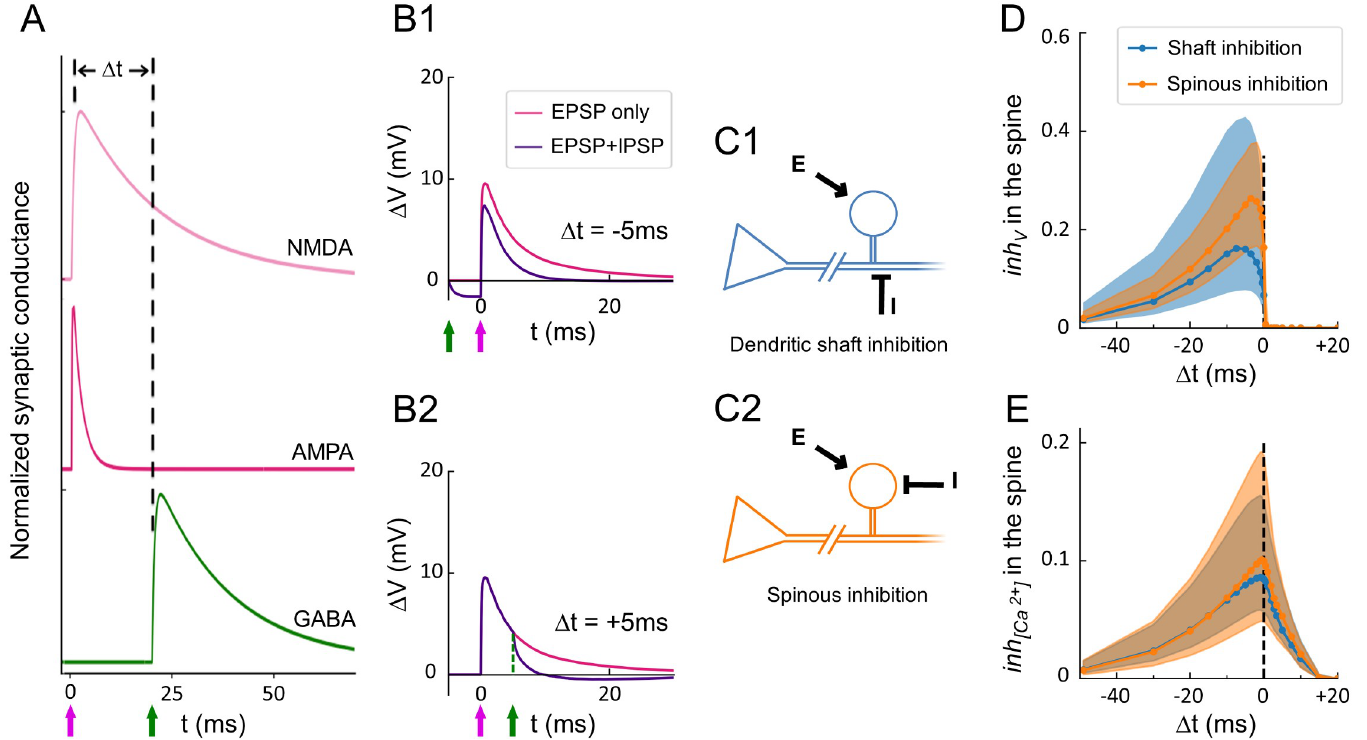
Fig 7. Input timing determines EPSP and IPSP integration and decoupling of voltage and calcium signals in DiSs. (A) Schematic: excitatory AMPA and NMDA conductances were activated at t = 0. The inhibitory GABAergic conductance was activated at an interval Δ t before or after the onset of excitation. (B) Examples of the time course of depolarization in the spine head for Δ t = +5 ms (B1) and Δ t = − 5 ms (B2) (purple curves) compared to no inhibition (magenta curves). Arrows represent the onset of excitatory and inhibitory inputs (magenta and green arrows, respectively). (C) Schematics: inhibition ( ┬ symbol) of an EPSP (arrow) by an IPSP elicited either in the shaft next to the spine (C1, blue) or directly in the spine head (C2, orange). (D) Voltage inhibition in the spine head, inh V , induced by dendritic (blue) or spinous , induced by dendritic (blue) or spinous (orange) IPSPs as a function of (orange) IPSPs as a function of Δ t. (E) Inhibition of the calcium influx in the spine head, inh [Ca 2+ ] Δ t. The data underlying this figure can be found in https://www.opendata.bio.ens.psl.eu/3DCLEM-Spines/data/Data_related_to_Fig 7.xlsx (login: guest; password: EnsData0811). AMPA, α -amino-3-hydroxy-5-methyl-4-isoxazolepropionic acid; DiSs, dually innervated spines; EPSP, excitatory postsynaptic potential; IPSP, inhibitory postsynaptic potential; NMDA,